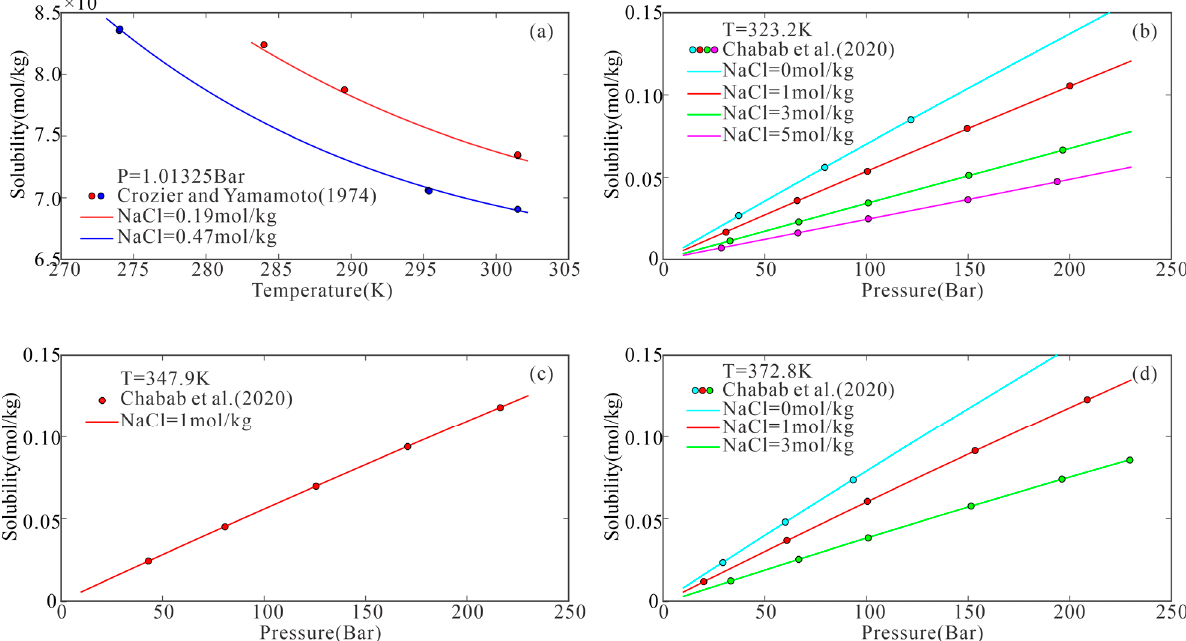
Figure 3. H 2 solubility versus pressure in aqueous NaCl solutions with different concentrations: model predictions (colored lines) and experimental data (colored circles). (( a ) The point reported by Crozier and Yamamoto [38]; ( b – d ) The point reported by Chabab et al. [21]; All the curves calculated using the proposed